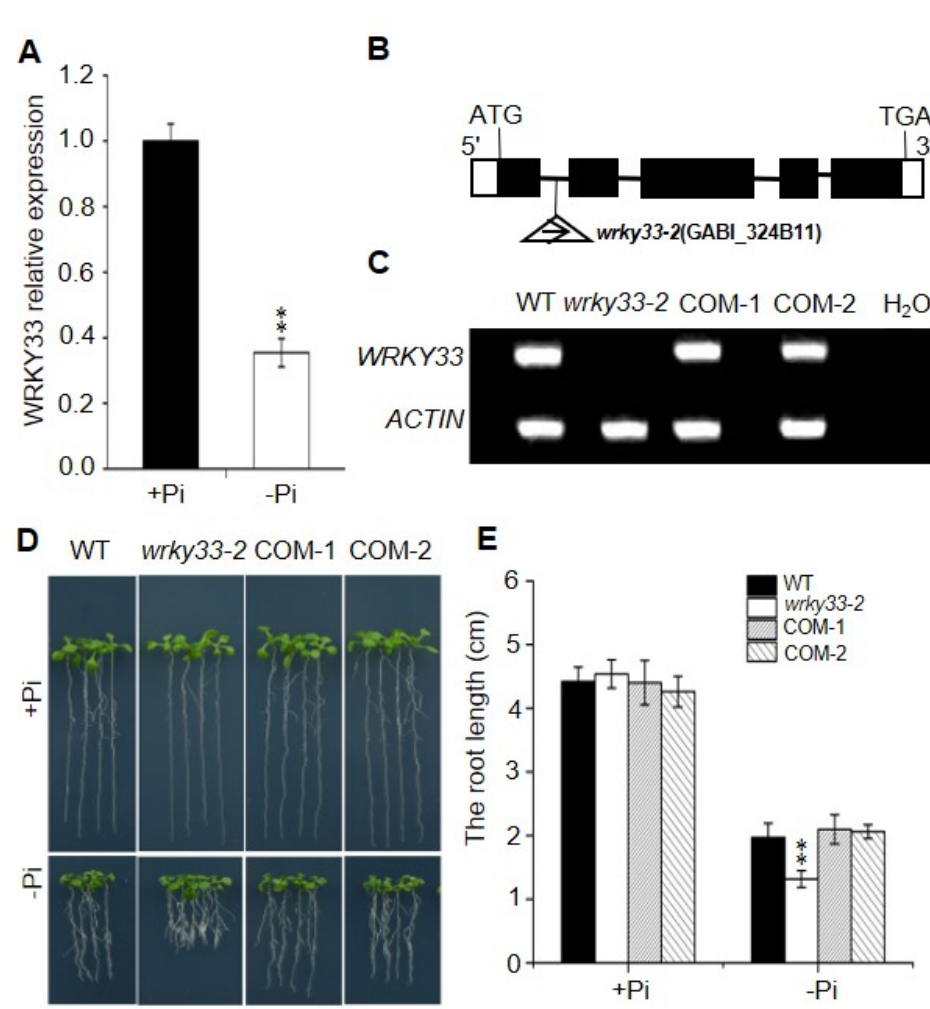
Figure 1. WRKY33 mediated the Pi-deficiency-induced root growth inhibition. ( A ) Quantitative reverse transcription polymerase chain reaction (qRT-PCR) analysis of WRKY33 expression level. Four-day-old wild-type (WT) plants were transferred to Pi-sufficient (+Pi) or Pi-deficienct ( − Pi) medium for 2 days. The WRKY33 expression under Pi-sufficient (+Pi) was set as 1.0, and the Pi-deficiency treatment level was normalized to the Pi-sufficient (+Pi) level. Data are mean ± SD from three replicate experiments. ( B ) Schematic map of T-DNA insertion location of wrky33-2 mutant. Black boxes, lines, and triangles represent exons, introns, and the position of the T-DNA insertion, respectively. The while boxes indicate the 5 (cid:48) or 3 (cid:48) UTRs. ( C ) RT-PCR analysis of the transcriptional level of WRKY33 in WT, wrky33-2, and complementation lines (COM-1, COM-2). Water was used as a negative control. ( D ) Growth phenotypes of WT, wrky33-2, COM-1, and COM-2. Four-day-old seedings were transferred to a Pi-sufficient (+Pi) or a Pi-deficient ( − Pi) medium for six days. ( E ) The statistical analysis of the primary root length as indicated in ( D ). Data are means ± SD from three independent experiments ( n = 15; n represents the number of samples). Asterisks in ( A , E ) indicate a significant difference from the WT (Tukey’s test; **, p <